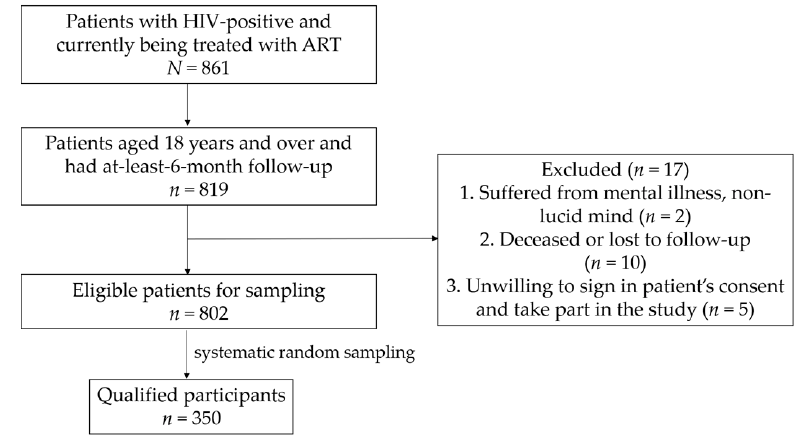
Figure 1. Diagram of the research steps.